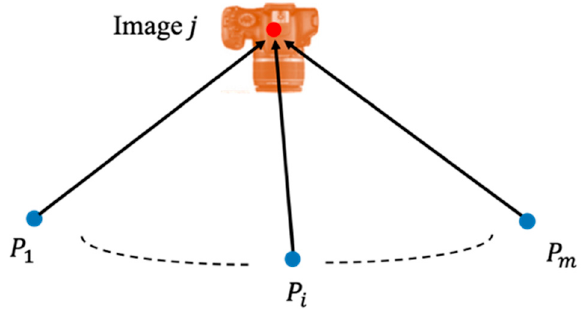
Figure 7. Estimation of the positional parameters of image 𝑗 through multiple object points. Compatibility Analysis for Image